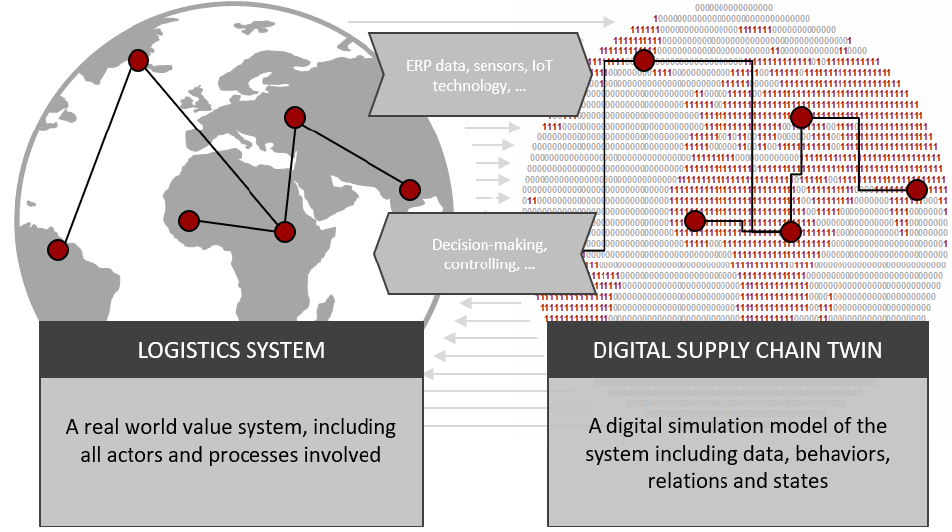
Figure 2. Concept of a Digital Supply Chain Twin (DSCT) (cf. [26]).